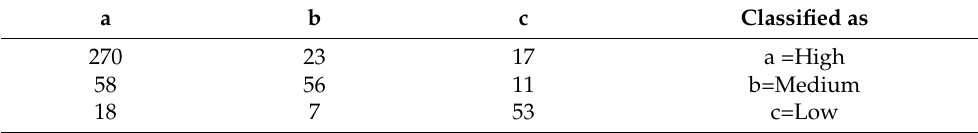
Table 1. Confusion matrix obtained for